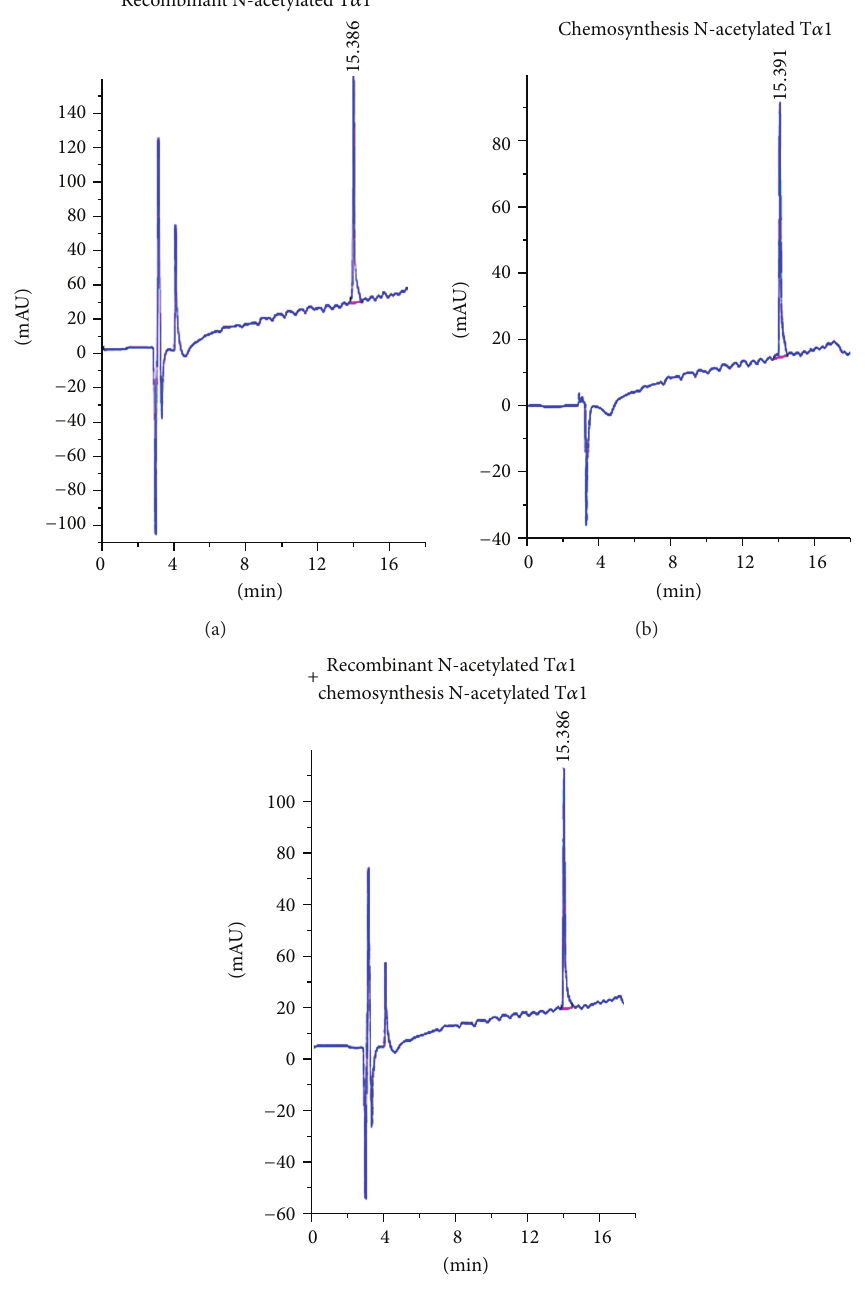
Figure 4: Identification of recombinant N 𝛼 -terminal acetylated Thymosin 𝛼 1 by RP-HPLC. Recombinant N 𝛼 -acetylated T 𝛼 1 was analyzed by RP-HPLC on a C18 column (5 𝜇 m, 4.6 × 250 mm) with a programmed acetonitrile gradient in 0.1% TFA, as detailed under “Materials and Methods.” Chromatograms are shown for (a) recombinant N 𝛼 -acetylated T 𝛼 1 (15.386 min), (b) chemically synthesized N 𝛼 -terminal acetylated T 𝛼 1 (ZADAXIN, 15.392 min), and (c) mixture of the recombinant T 𝛼 1 and chemically synthesized T 𝛼 1 (15.392